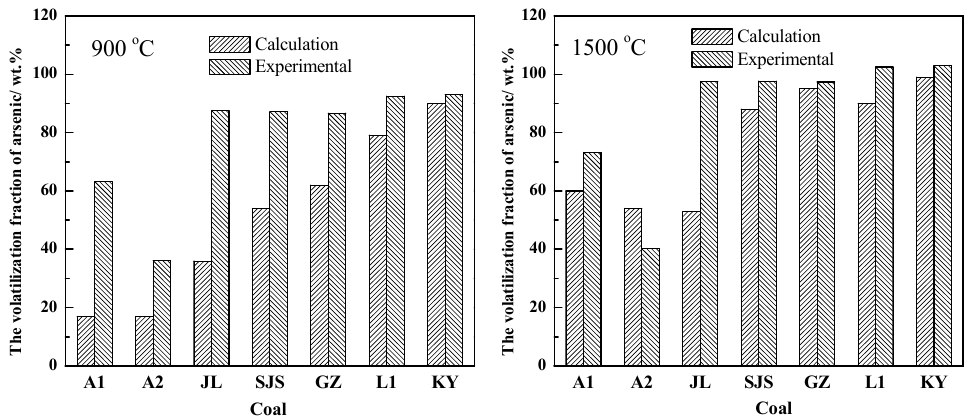
Figure 8. Predicted and experimental values of arsenic volatilization during coal combustion under different temperatures. Table 4. Experimental and predicted results of arsenic vaporization during SH combustion under 1100 °C.